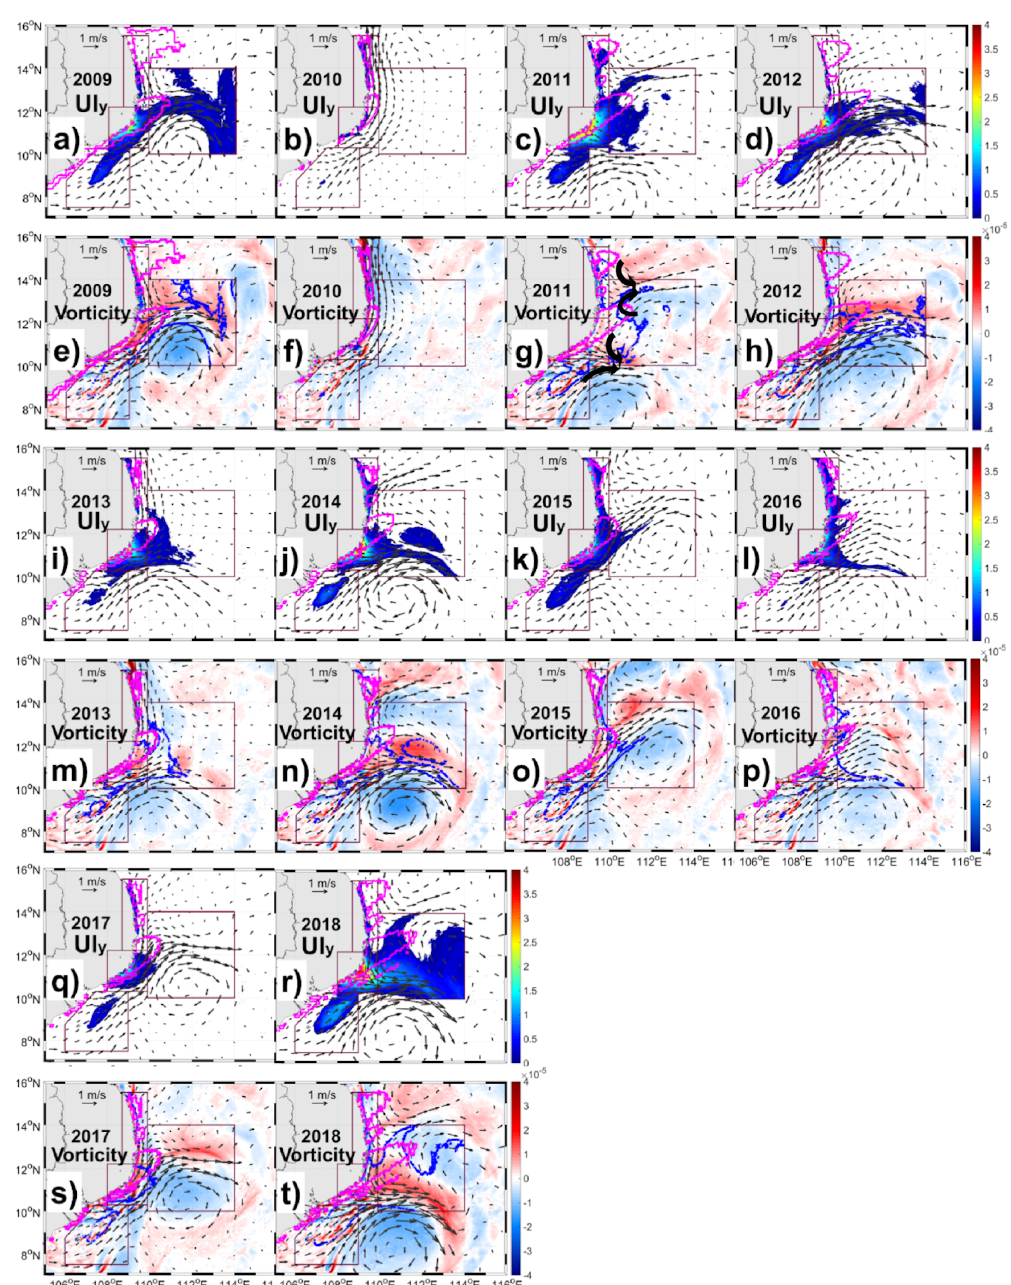
Figure 12. Maps of spatial yearly upwelling index UI y ( ◦ C, a, b, c, d, i, j, k, l, q, r ) and of speed and direction (arrows, ms − 1 ) and vorticity (colors, s − 1 ) of JJAS-averaged surface current (e, f, g, h, m, n, o, p, s, t) for each year of the simulation. Pink contours show the + 3.10 − 7 Nm − 3 isoline of JJAS average positive wind stress curl. Blue contours show the 0.1 ◦ C isoline of UI y